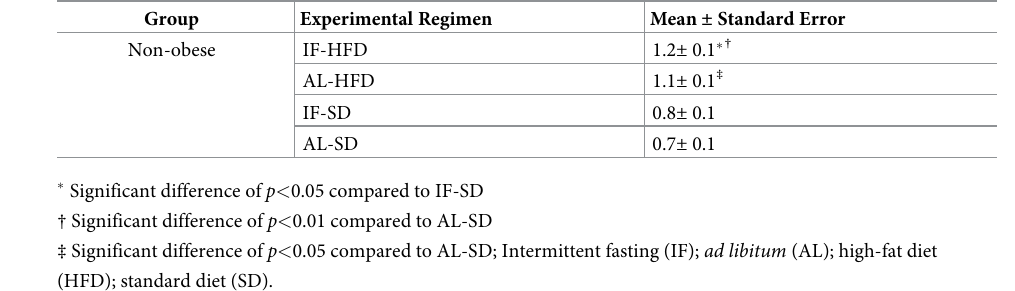
Table 3. Blood ketone levels in non-obese control rats.